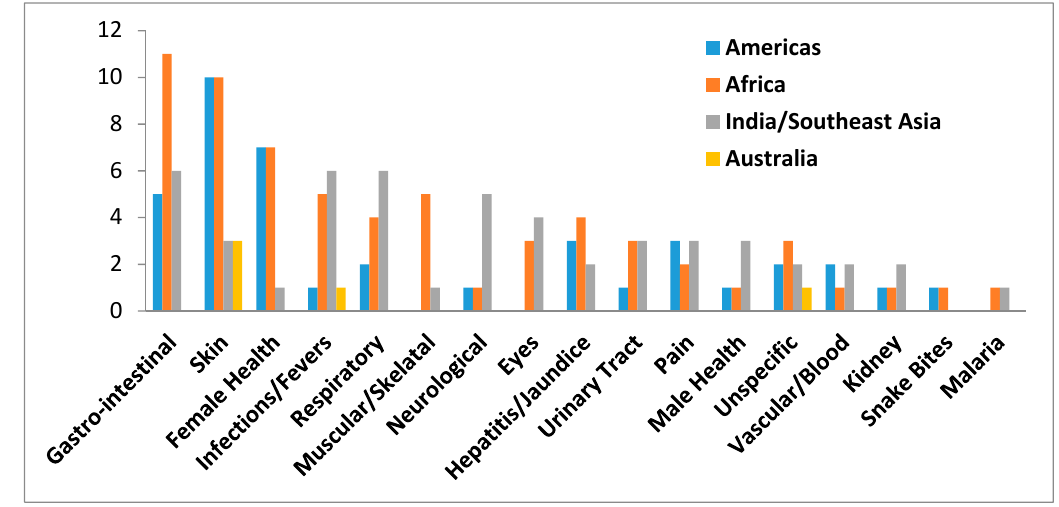
Figure 4. Number of different types of uses ( y -axis) per major category of medicinal use ( x -axis) for species of Cochlospermaceae in the Americas, Africa, India/Southeast Asia, and Australia.